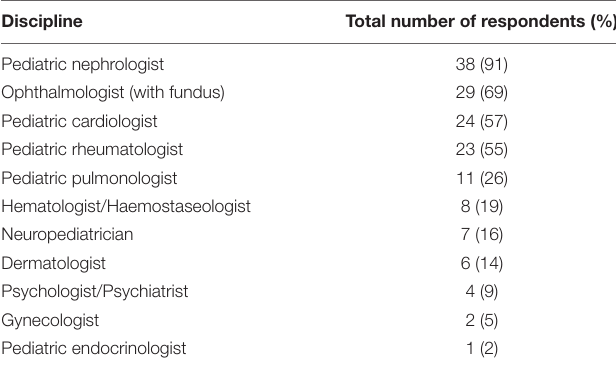
TABLE 1 | Consultants involved in the diagnosis and treatment planning of an SLE patient with suspected LN.